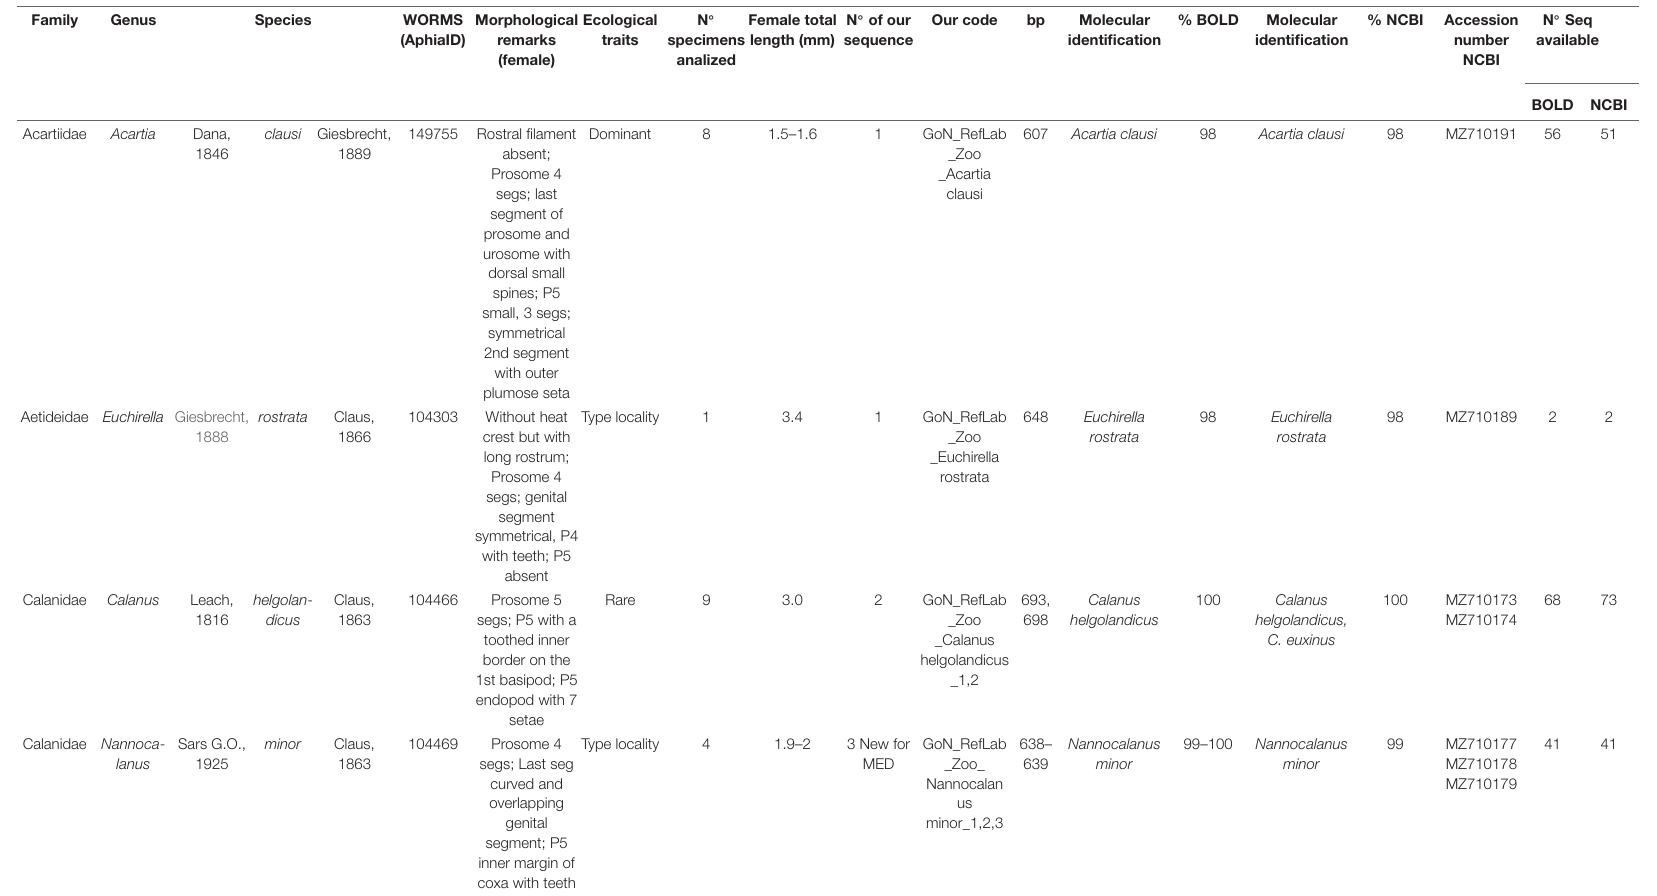
TABLE 1 | Summary of ecological traits, morphological remarks, morphometric analyses and molecular data of the species studied. Family Genus Species WORMS